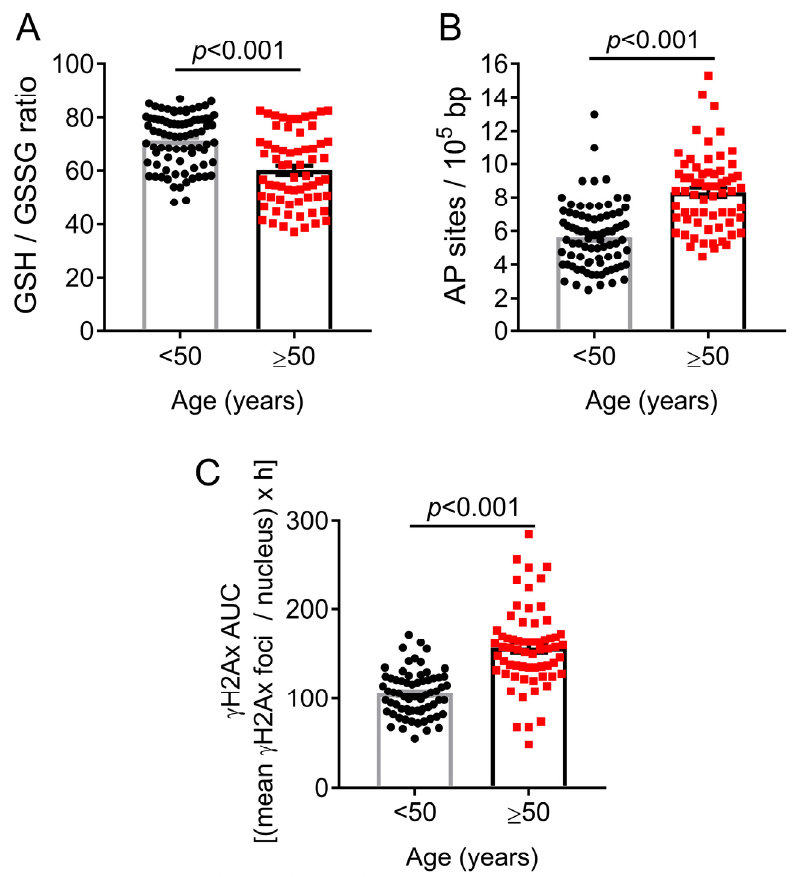
Figure 3. Oxidative stress, abasic sites and DSBs repair capacity in PBMCs. Bar graphs showing ( A ) the oxidative stress levels expressed as the ratio of reduced-to-oxidized glutathione (lower ratio is an indication of higher oxidative stress levels) (GSH/GSSG mean ± SEM: <50 = 71.6 ± 1.1; ≥ 50 = 60.2 ± 1.7), ( B ) the apurinic/apyrimidinic (AP) sites (AP sites/10 5 nucleotides mean ± SEM: <50 = 5.7 ± 0.2; ≥ 50 = 8.3 ± 0.3) and ( C ) the melphalan-induced accumulation of γ H2AX foci (expressed as AUC over 24 h incubation) in healthy individuals younger and older than 50 years ( γ H2AX AUC over 24 h mean ± SEM: <50 = 105.4 ± 3.1; ≥ 50 = 157.1 ± 5.6). The experiments shown were based on a minimum of 3 independent repeats. The p -values are derived from Mann–Whitney U test. Bars and error bars represent mean and standard error of the mean (SEM).